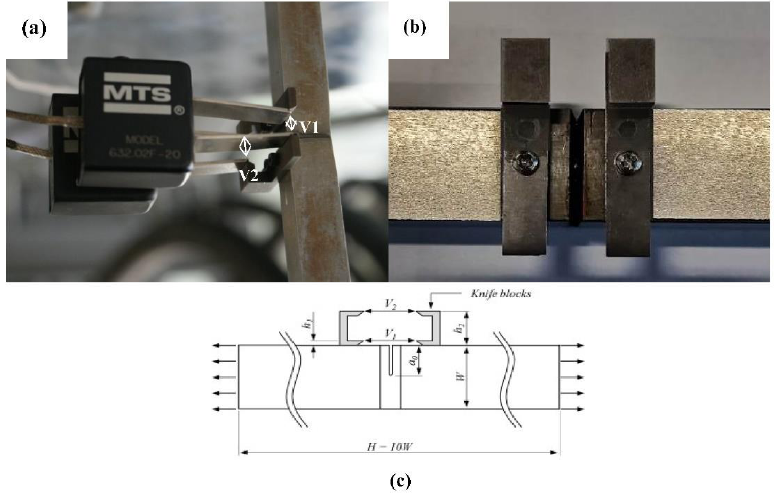
Figure 6. Single-edge notch tensile test. ( a ) Test with two MTS extensometers; ( b ) The tooling used to install the extensometers; ( c ) Schematic diagram of SENT.